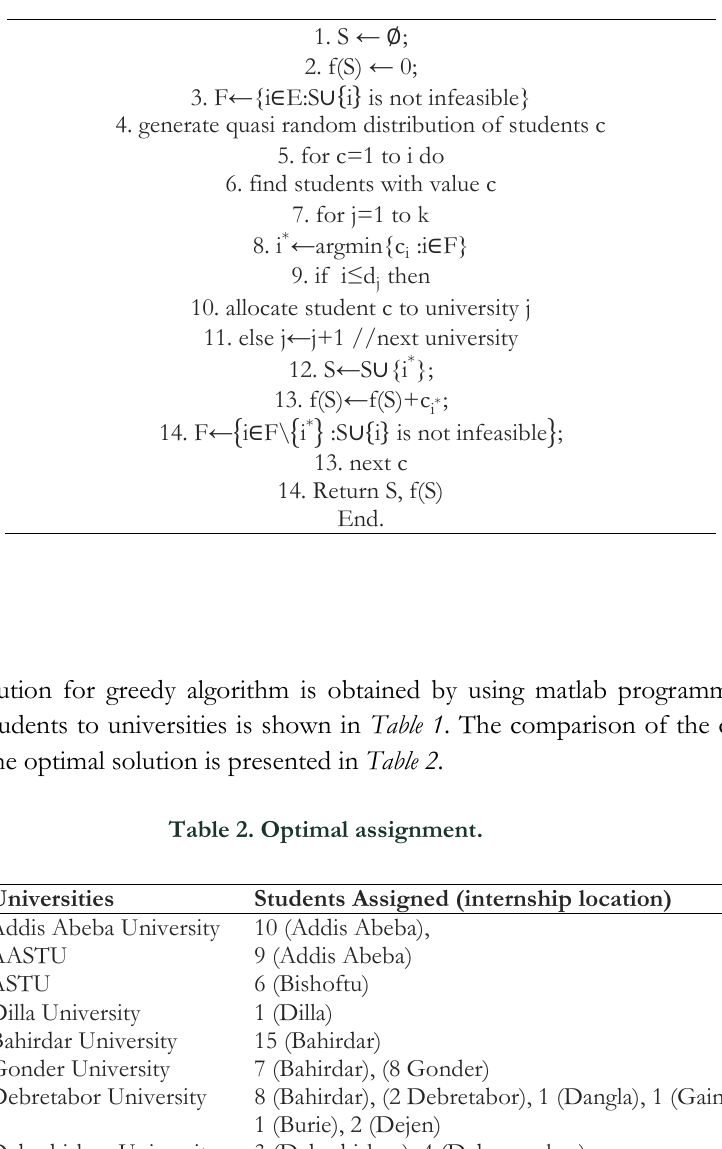
Table 1. Random greedy algorithm.